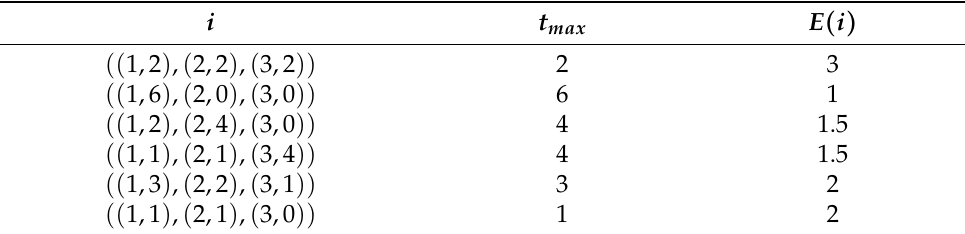
Table 21. Partial solution evaluation function values for random SAT